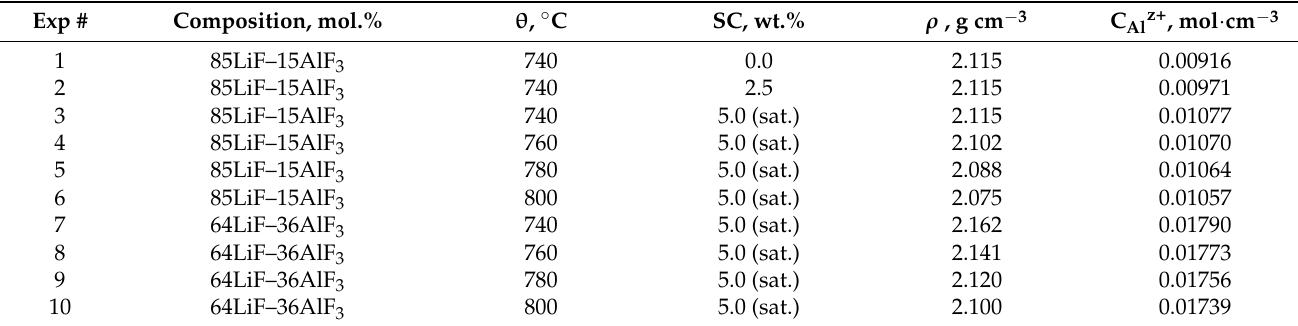
Table 1. Composition and properties of studied systems ( θ is the temperature, SC is the spent catalyst content, ρ is the density, C Alz+ is the concentration of Al ions).